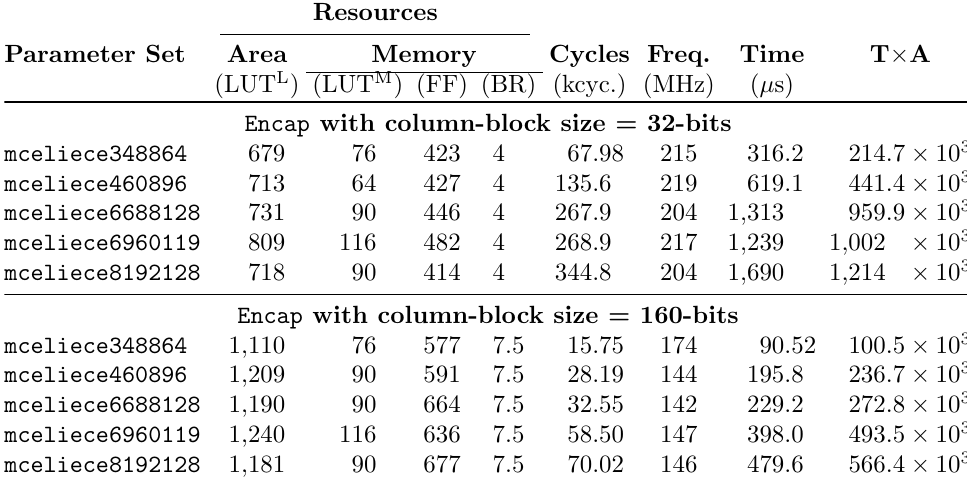
Table 9: Comparison of the time and area for our Encap hardware module for column-block sizes 32-bits and 160-bits targeting Xilinx Artix 7 ( xc7a200t )